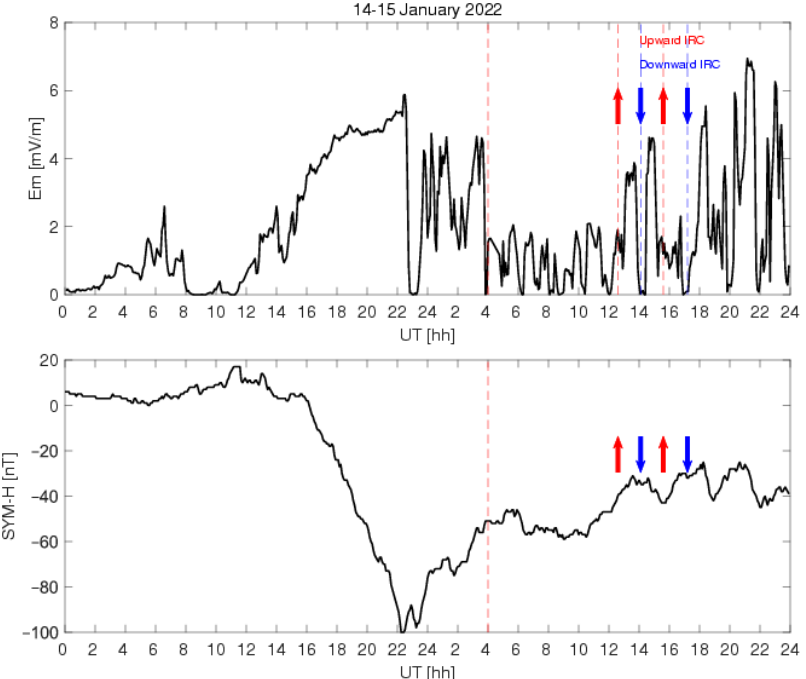
Figure 1. Temporal variations in Em and the SYM-H index from 14–15 January 2022. The vertical red dashed line denotes the onset of the Tonga volcanic eruption. The red arrows denote radially upward FRC variations, and while the blue arrows denote radially downward FRC fluctuations.